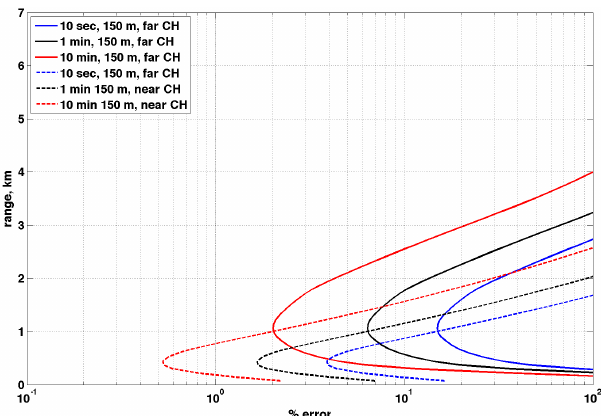
Figure 8. Daytime performance estimate in relative error (%) for temporal resolutions of 10s, 1min, and 10min with a spatial reso- lution of 150m for an online column OD of 1.5 The model results indicate that 1min, 150m resolution may be useful for boundary layer